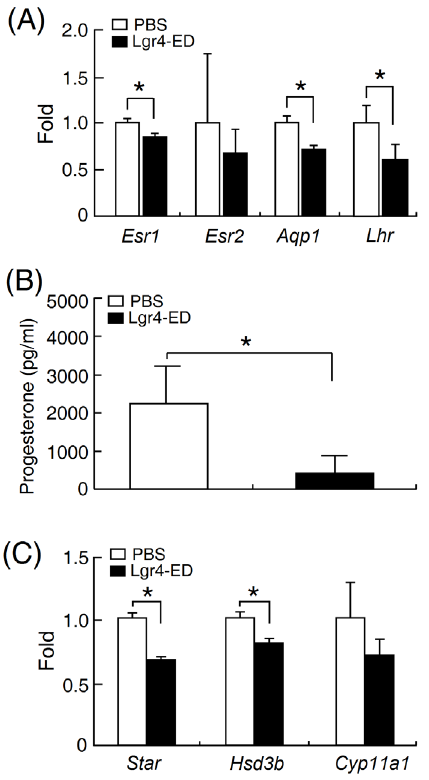
Figure 7. The recombinant Lgr4-ED protein decreases gonad- otropin-driven ovarian development and steroidogenesis. Immature female rats (26 days old) were intraperitoneally injected with PMSG in the presence or absence of 20 m g Lgr4-ED. The ovaries were harvested two days later for assessing the expression levels of (A) Esr1, Esr2, Aqp1 and Lhr . b -actin was used for normalization. (all bars; n=7). In addition, (B) the progesterone amounts and (C) the transcript levels of various steroidogenic genes in the ovaries were evaluated (n=4). Data are shown as the mean 6 SEM. Asterisks indicate P , 0.05.